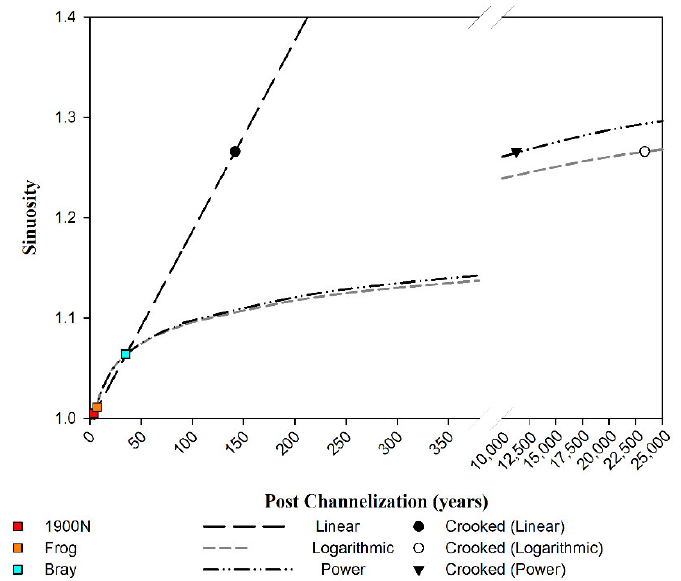
Figure 4. Sinuosity of the modified streams (1900N, Frog Creek, and Bray Creek) versus time since channelization. Crooked Creek sinuosity values are modeled using a linear (black dashed line), a logarithmic (gray dashed), and a power (black dash–dot–dot line) relationship. Note the x-axis has a break between 380 and 10,000 years.